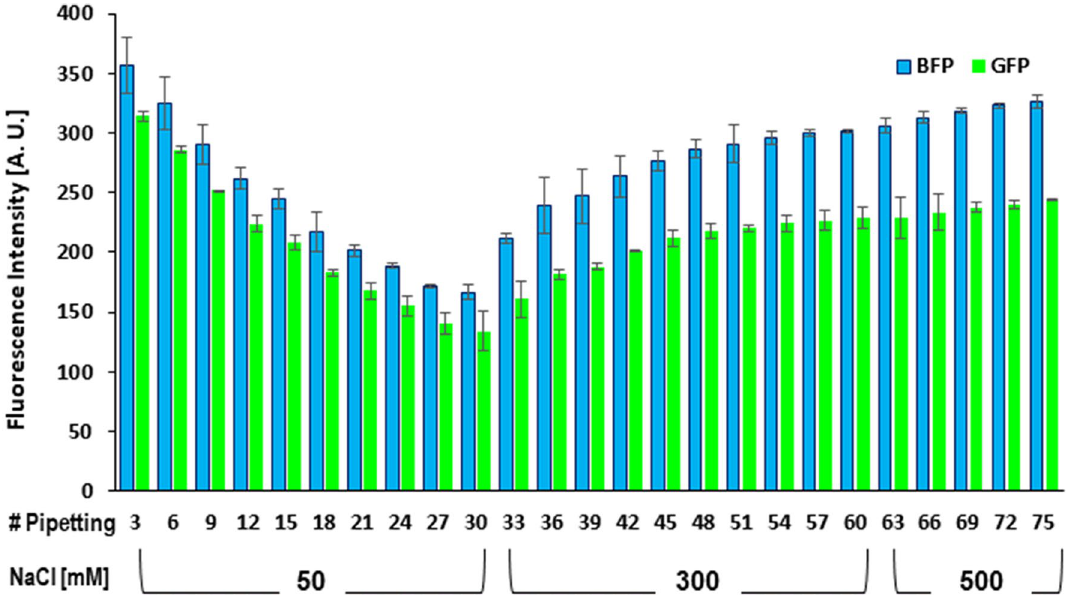
Figure 7. The effect of NaCl on FUS aggregation caused by pipetting. A fluorescence spectrum of 100 nM FUS fusion protein (MBP-BFP-FUS-GFP-6xHis) was measured at an initial NaCl concentration of 50 mM. Then, spectra were recorded after every three strokes of pipetting until the cumulative stroke number of 30. After that, the NaCl concentration was increased to 300 mM. Then, a total number of thirty stokes of pipetting was applied in the same way. After that, NaCl was further increased to 500 mM. Then, a total number of fifteen stokes of pipetting was applied similarly. Blue and green bars represent the BFP and GFP fluorescence intensities, respectively. The averages of two independent experiments ± standard deviation (SD) are